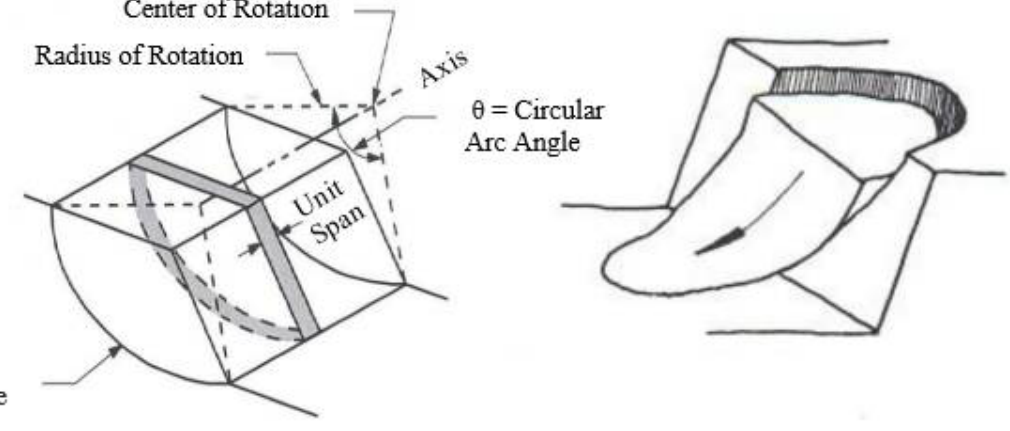
Figure 7. Rotational failure mode and circular failure mode in slopes (Adapted from [5]).